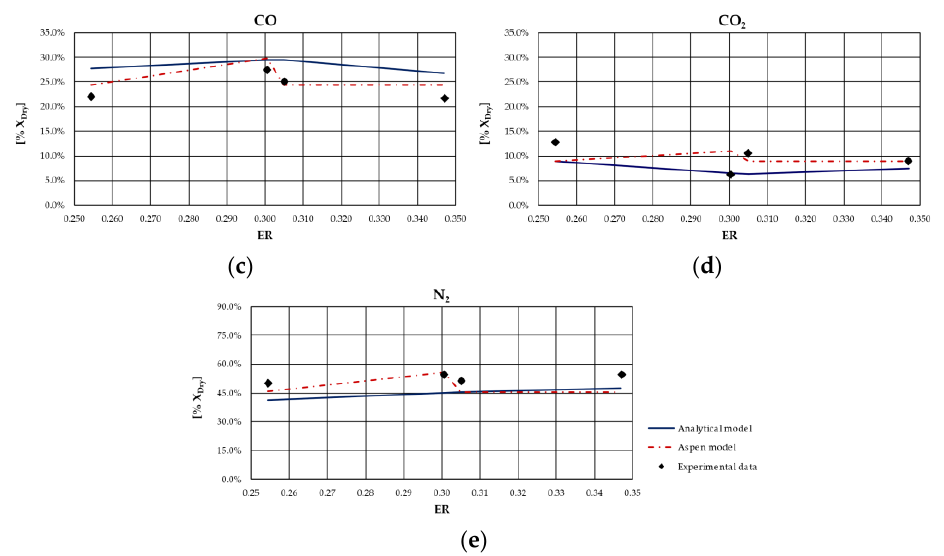
Figure 5. Comparison of syngas mole fraction composition between the results of calibrated and non-calibrated analytical and Aspen models and experimental data from wood pellet gasification [68]: ( a ) CH 4 mole fraction; ( b ) H 2 mole fraction; ( c ) CO mole fraction; ( d ) CO 2 mole fraction; ( e ) N 2 mole fraction.